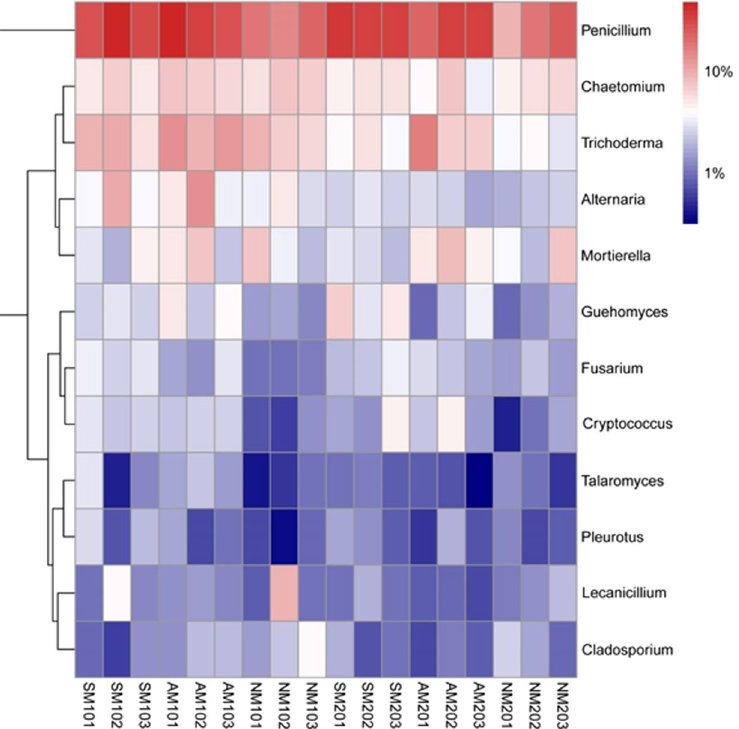
Figure 5. Heat map showing the abundance of fungal genera in each sample (the genera with an average abundance greater than 0.5% in one group were defined as abundant). The colour intensity (log scale) in each panel shows the percentage of a genus in a sample; please refer to colour key at the right bottom.